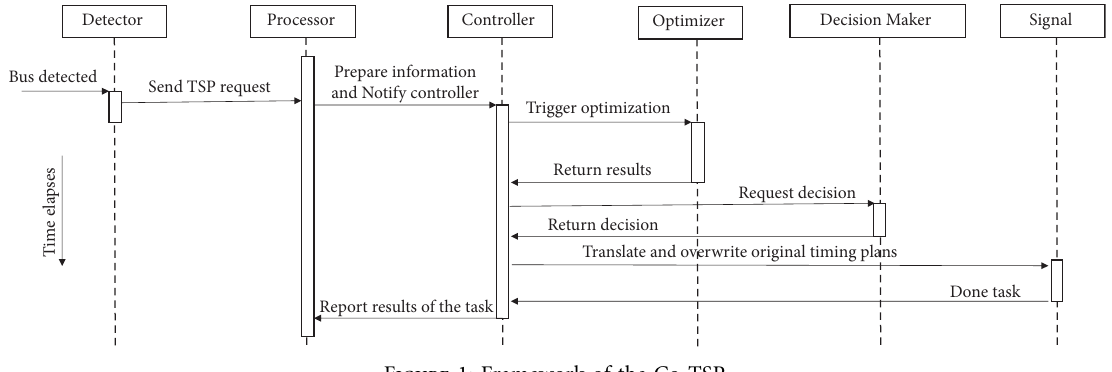
Figure 1: Framework of the Co-TSP.